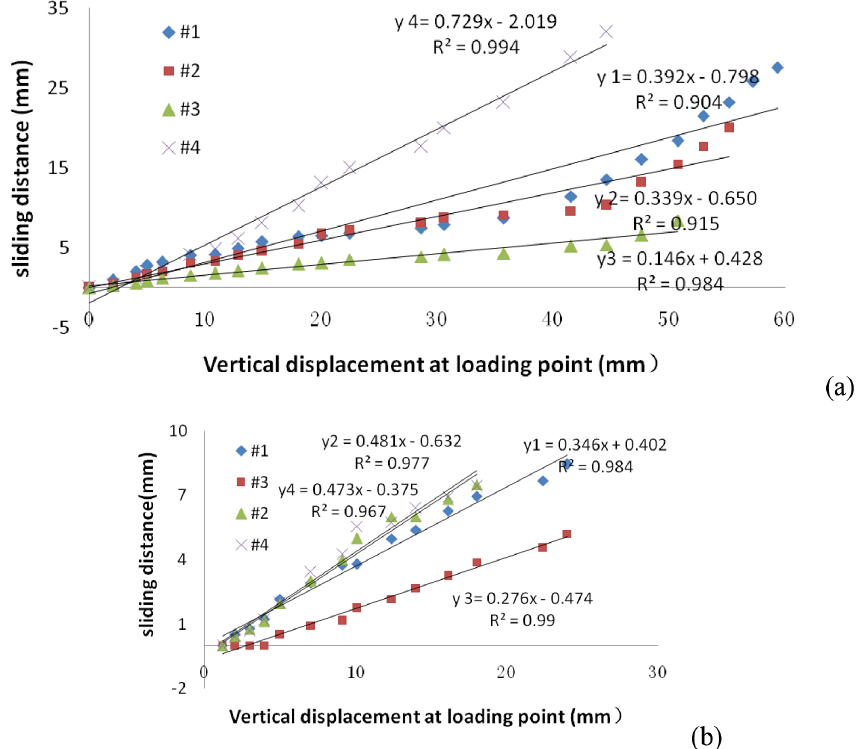
Figure 3. Relationship between fiber optical sliding distance and vertical displacement at loading point. (a) Model 1, (b) model 2.